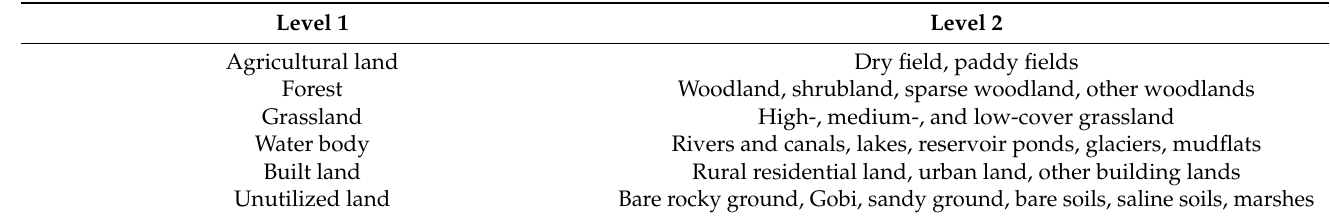
Table 3. LULC data level 1 and level 2 comparison